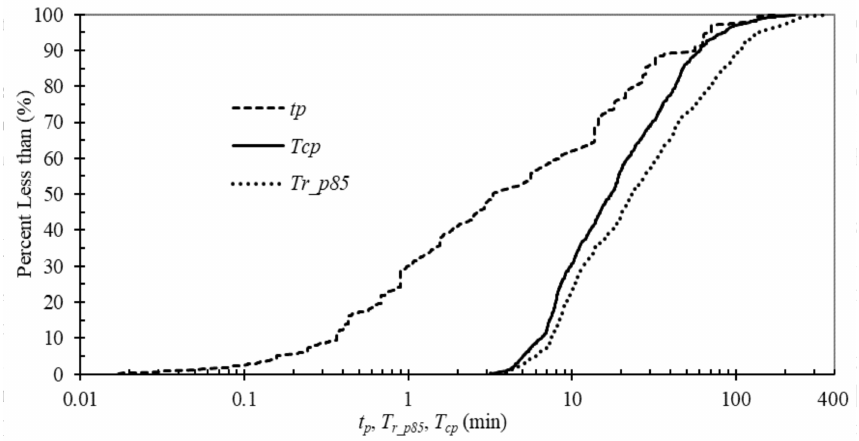
Figure 7. Cumulative distributions of calculated ponding time t p from Equation (9), time of 85% of particles to arrive at the outlet T r_p85 , and time of concentration T cp of pervious surfaces for 750 modeling